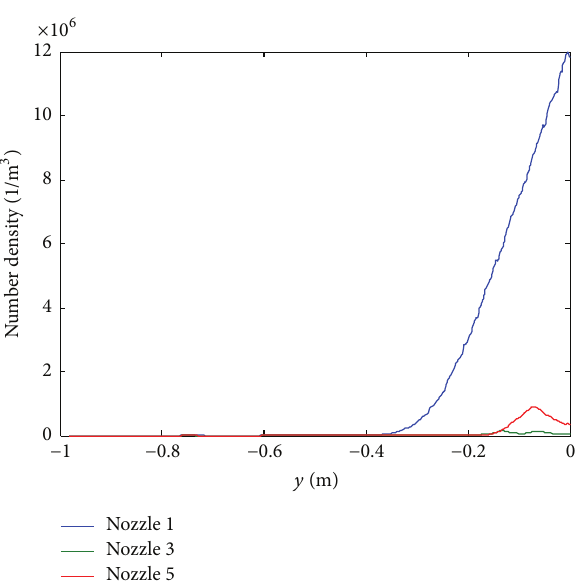
Figure 10: Plot of the number density of bin fraction